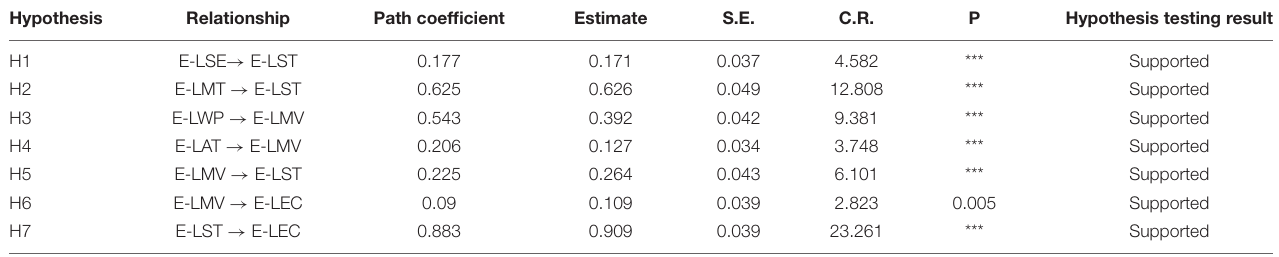
TABLE 4 | Structural path analysis result.